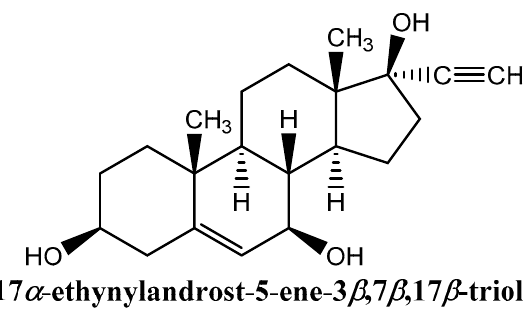
Figure 3. Synthetic sterol with insulin-sensitivity improvement activity [29].